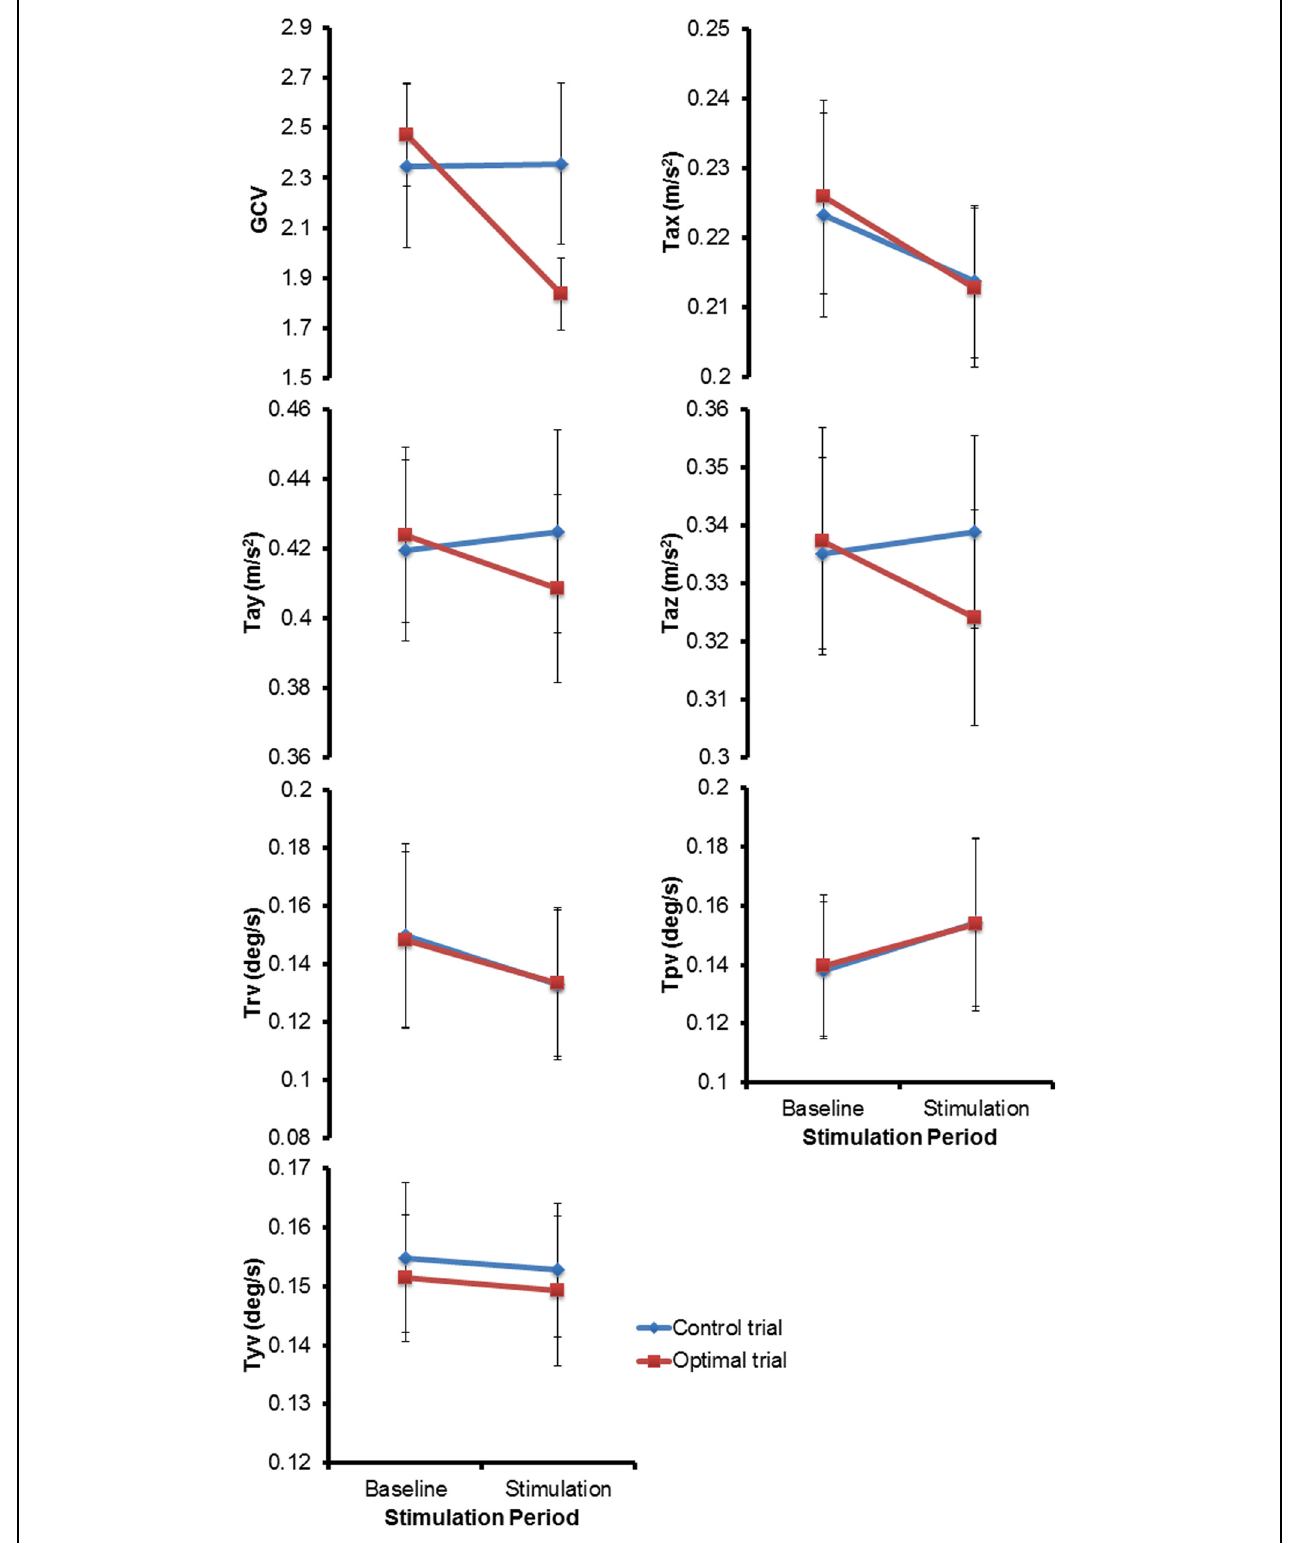
FIGURE 3 | The mean ( ± 1 SEM) values across all subjects ( n = 13) for all the seven parameters of interest during the two periods (baseline and stimulus) of the control and optimal trials.